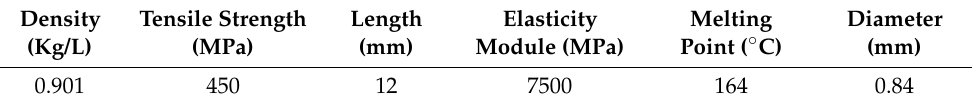
Table 5. Properties of Polyolefin